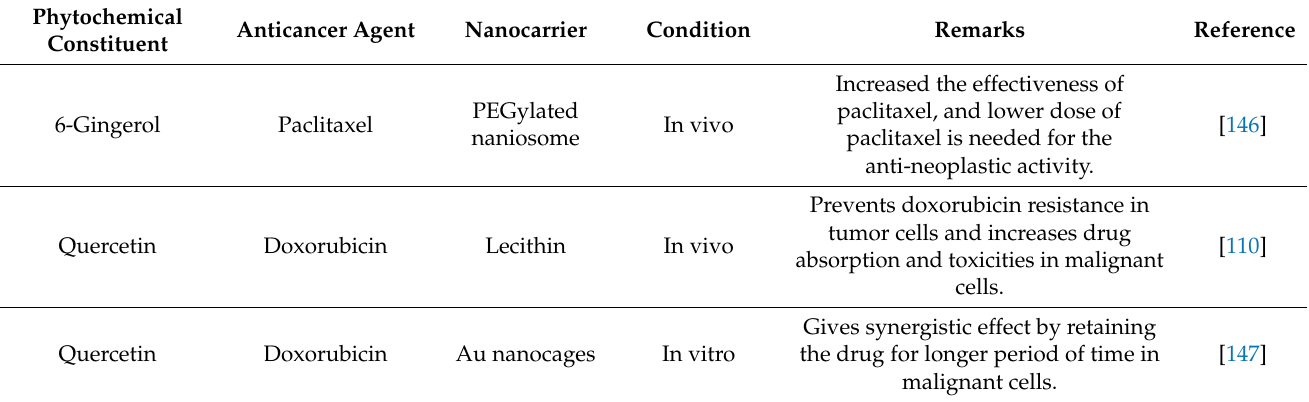
Table 3. Preclinical studies utilizing phytochemical nanocarriers for breast cancer treatment.